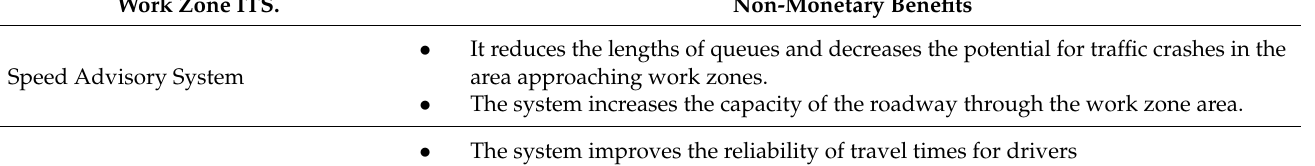
Table 7. Non-monetary benefits of the deployment of work zone ITSs. Work Zone